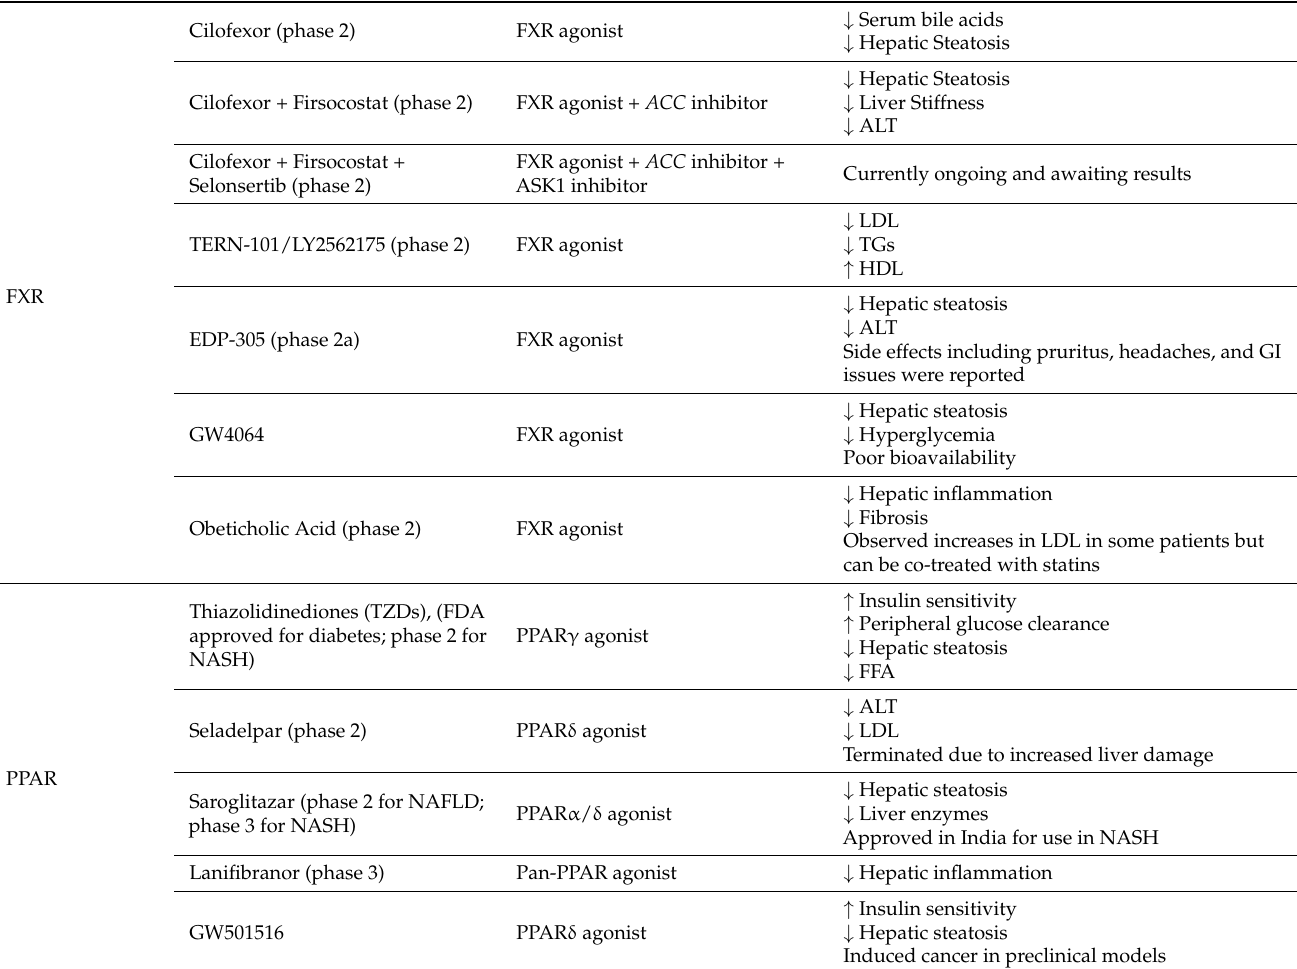
Table 1. Summary of NR compounds in NAFLD and NASH studies. Up arrow ( ↑ ) indicates an increase while a down arrow ( ↓ ) indicates a